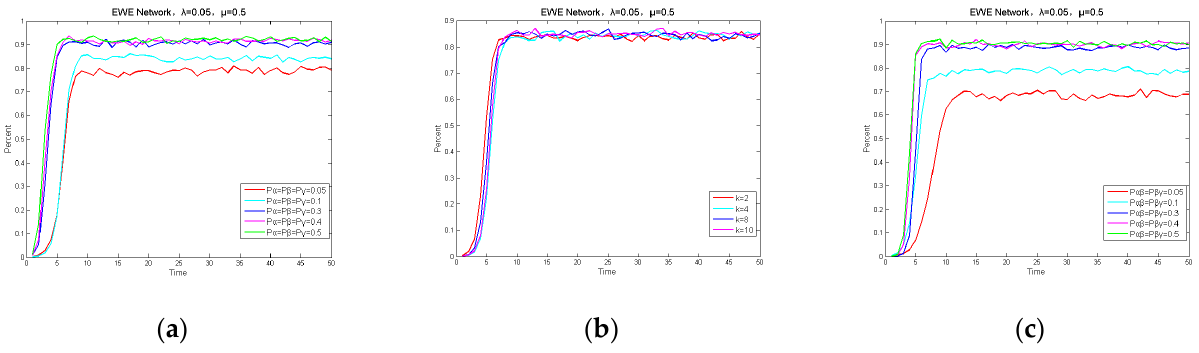
Figure 8. Influence analysis of the three-layer complex network EWE’s parameters on spreading procedure, ( a ) shows the influence of the intra-layer link probability, ( b ) shows the influence of K value, ( c ) shows the Influence of inter-layer link probability.